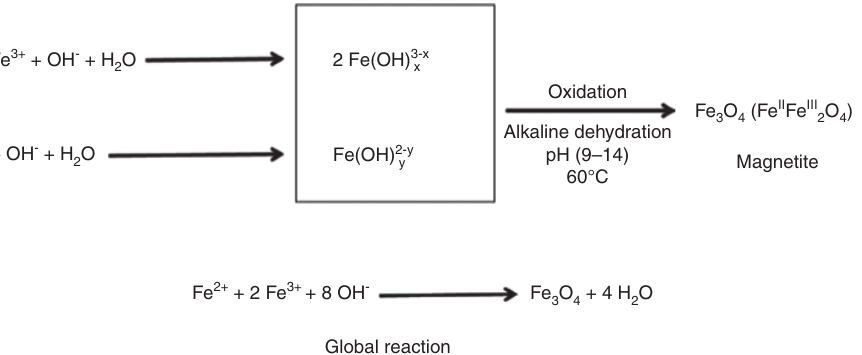
Figure 2: Diagram illustrating the mechanism of synthesis of magnetite nanoparticles in an aqueous solution of ferric and ferrous salts by addition of a base, where x and y represent the number of molecules OH -